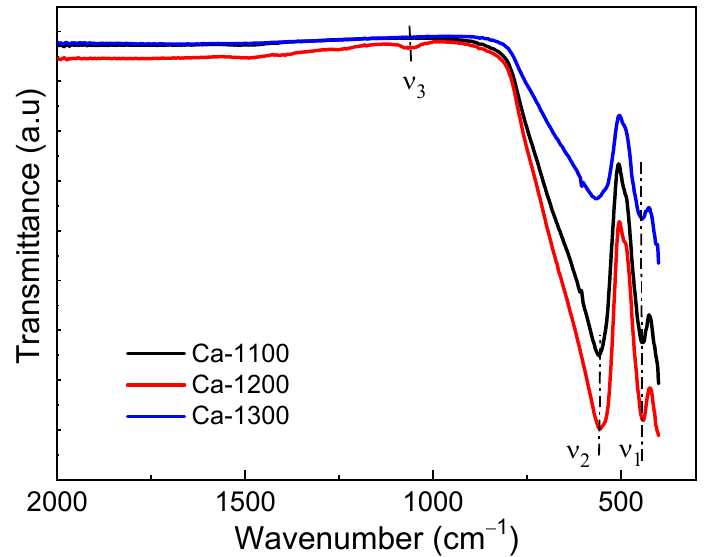
Figure 2. FTIR spectra of Ca-1100, Ca-1200, and Ca-1300 ceramic samples.